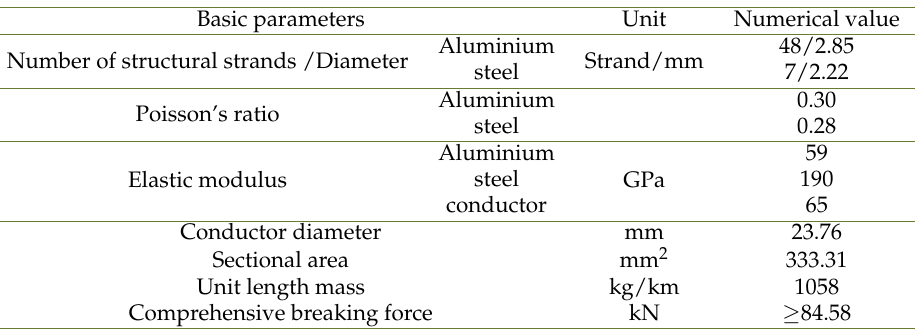
Table 1. Material parameters of ACSR LGJ-300/25